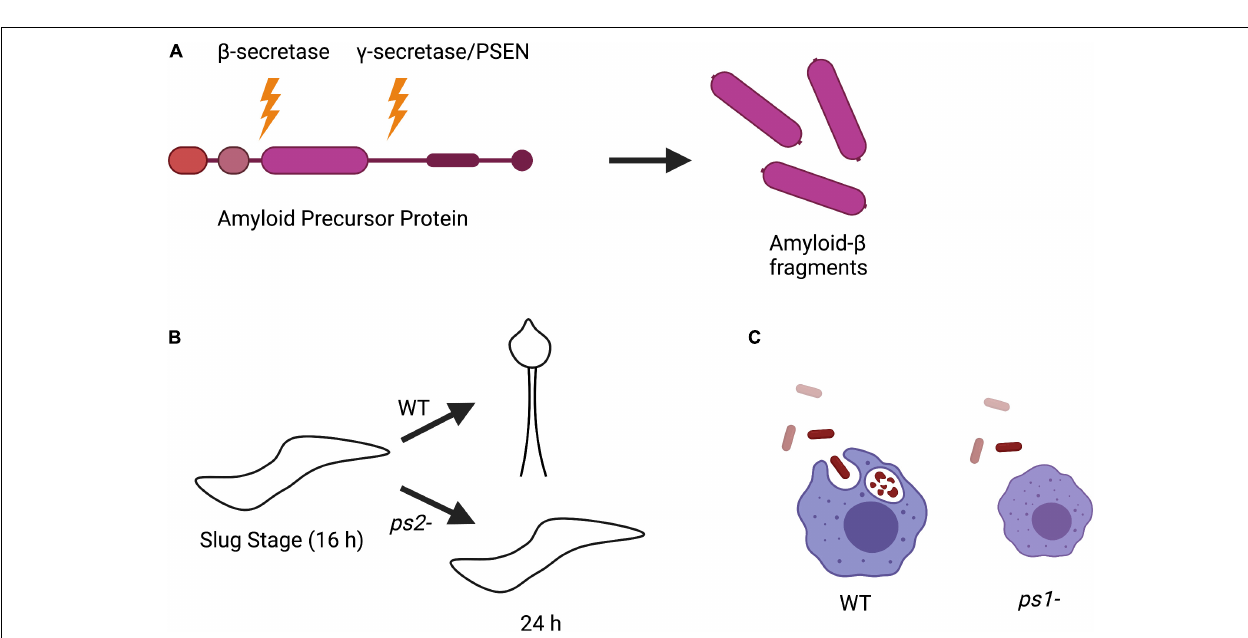
FIGURE 3 | Amyloid precursor protein (APP) processing and phenotypes of Dictyostelium PSEN knockout strains. (A) Processing of APP in human cells begins with initial cleavage by a β -secretase enzyme, followed by cleavage by presenilin in the γ -secretase complex to produce amyloid- β fragments. (B) Knockout of PSEN2 ( ps2 -) in Dictyostelium causes impaired ability to differentiate into pre-stalk cells during development and are unable to sporulate compared to wild-type (WT) cells. (C) Knockout of PSEN1 ( ps1 -) in Dictyostelium results in smaller cell size and defective phagocytosis compared to WT.